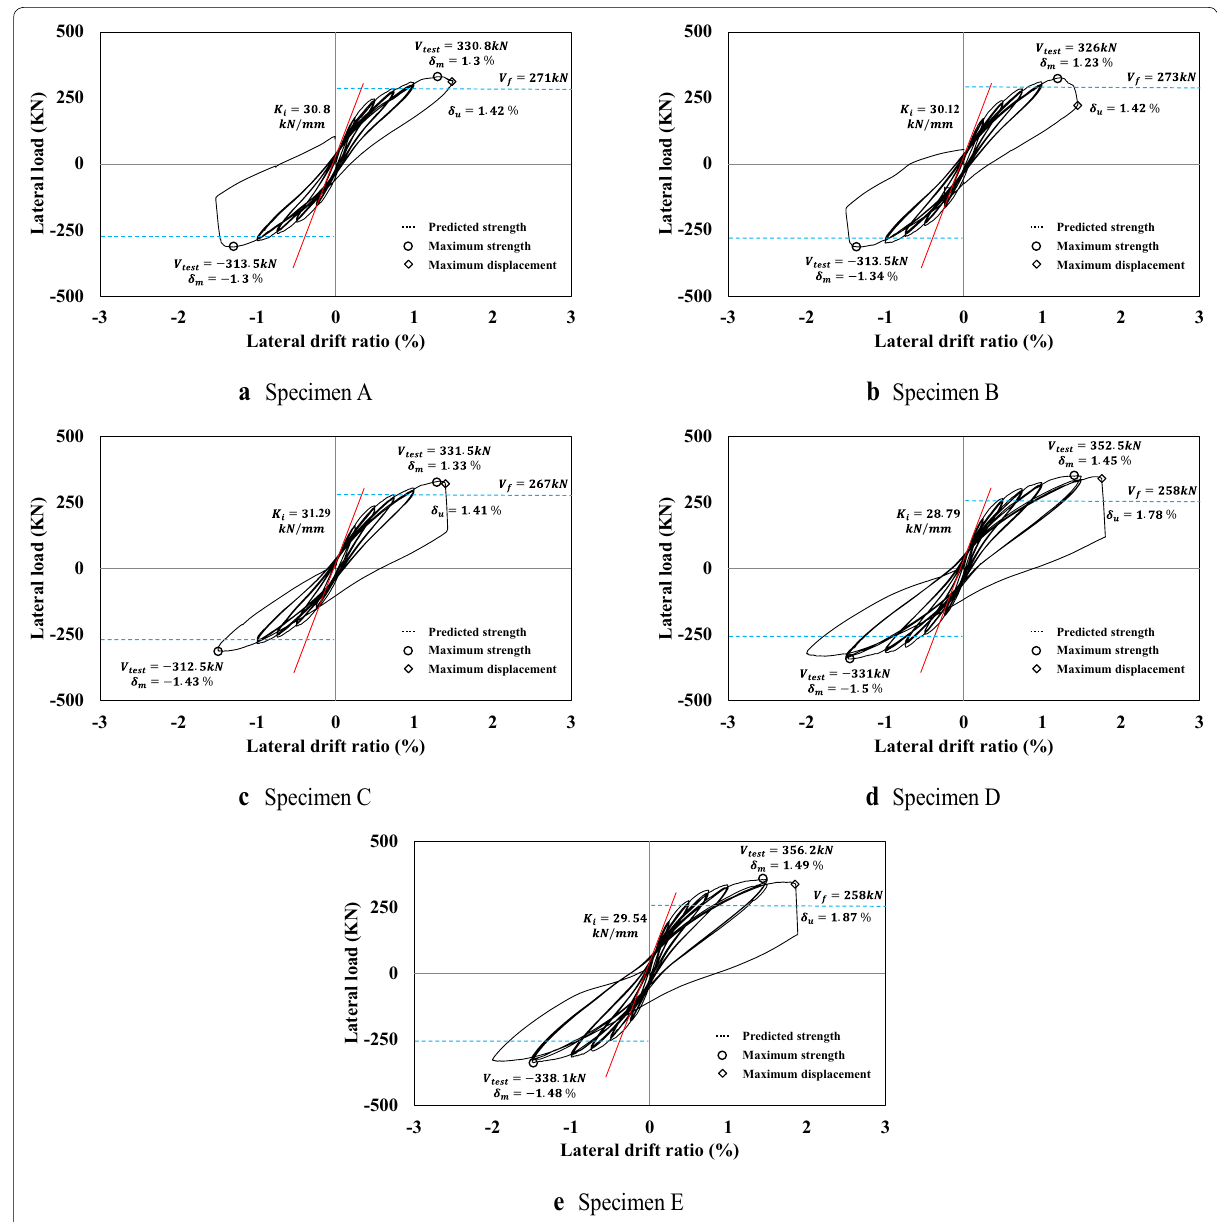
Fig. 8 Lateral load–drift ratio relationship of